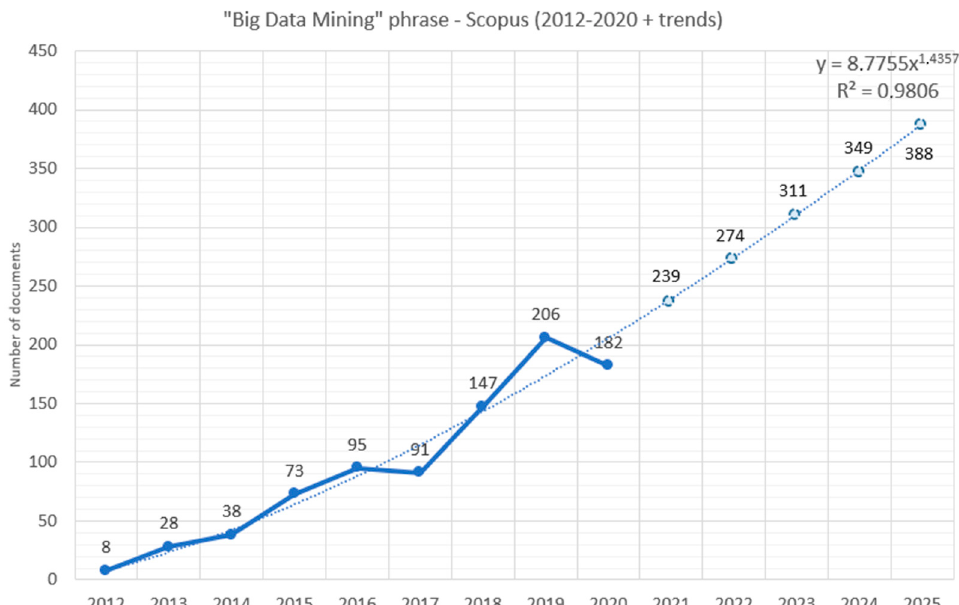
Figure 15. Time series for articles from the Scopus database corresponding to the phrase “big data mining” (for the years 2012–2020) with the power trendline (with the highest value of R 2 ) and fore- casted values (absolute) for the years